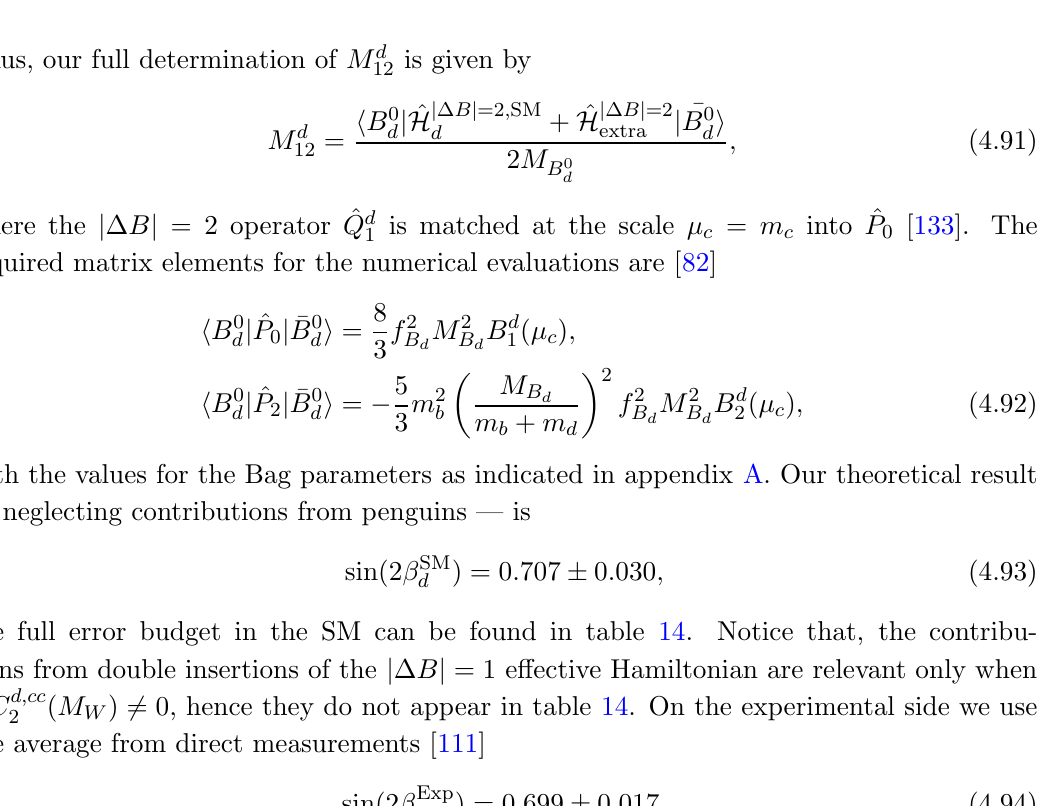
Table 14 . Error budget for the observable sin(2 (cid:12) d